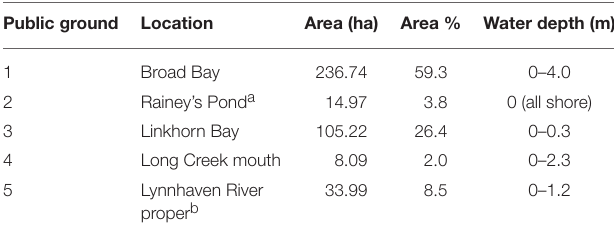
TABLE 2 | Public oyster grounds in the Lynnhaven River subestuary defined by (Baylor, 1893, 1894, 1895) as those areas where natural oyster reefs, beds, or shoals occurred during his surveys.